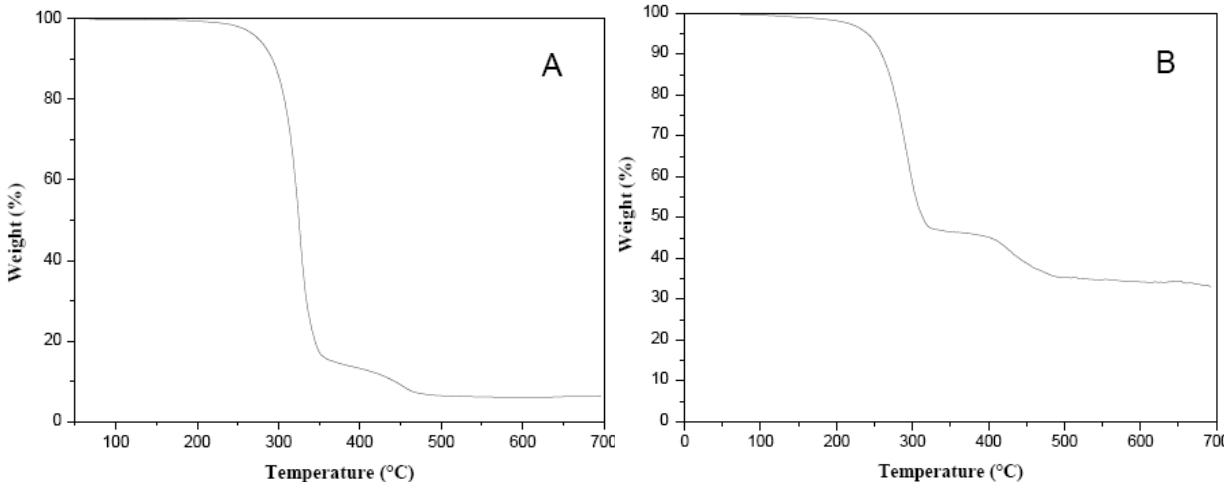
Figure 5. TGA-thermograms of pure thiolate compounds: ( A ) gold dodecyl-thiolate; and ( B ) lead dodecyl-thiolate. The residual weight corresponds respectively to the metal (Au) and metal sulfide (PbS) percentage in the thiolate